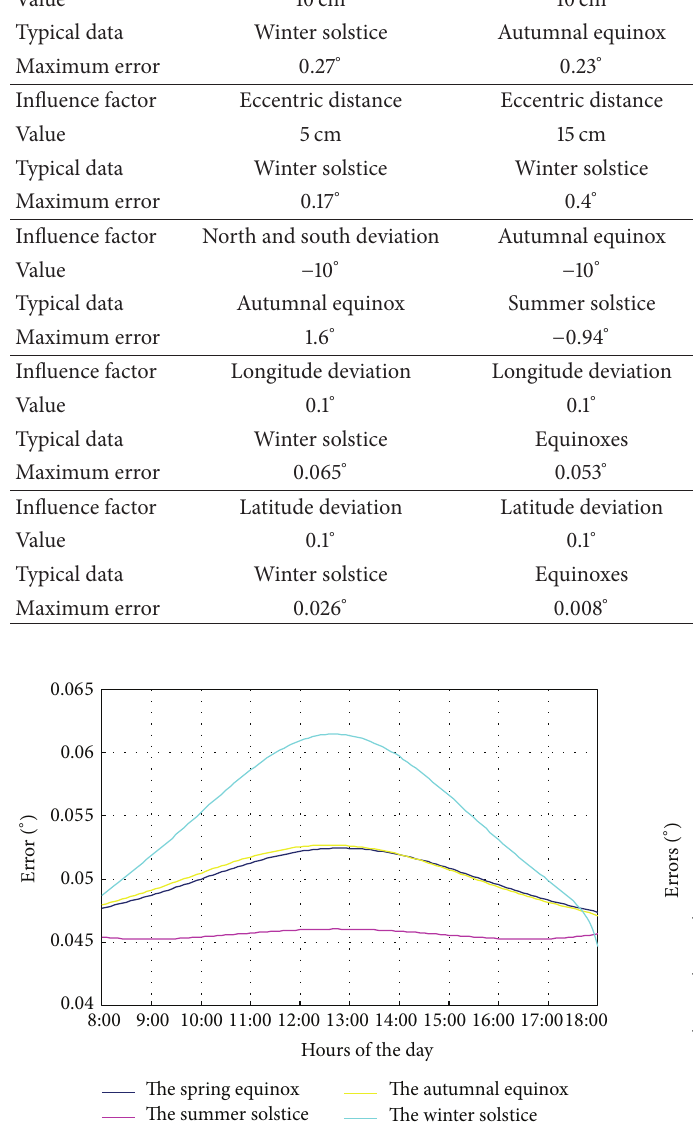
Figure 9: The tracking error of latitude 0.1 ∘ deviation.